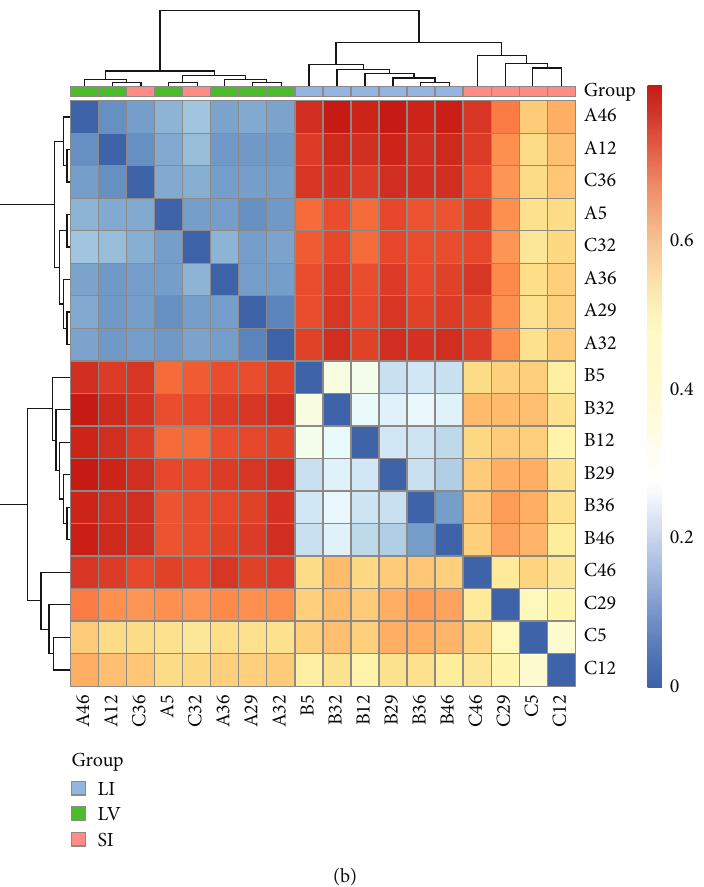
Figure 6: Relationship between liver and intestinal bacteria. The distance from the liver to the small intestine was smaller than that from the liver to the large intestine (genus level, binary Jaccard method). (a) Unweighted pair group method with arithmetic mean (UPGMA) analysis. (b) Distance heat map between samples. LV: liver; LI: large intestine (feces); SI: small intestine